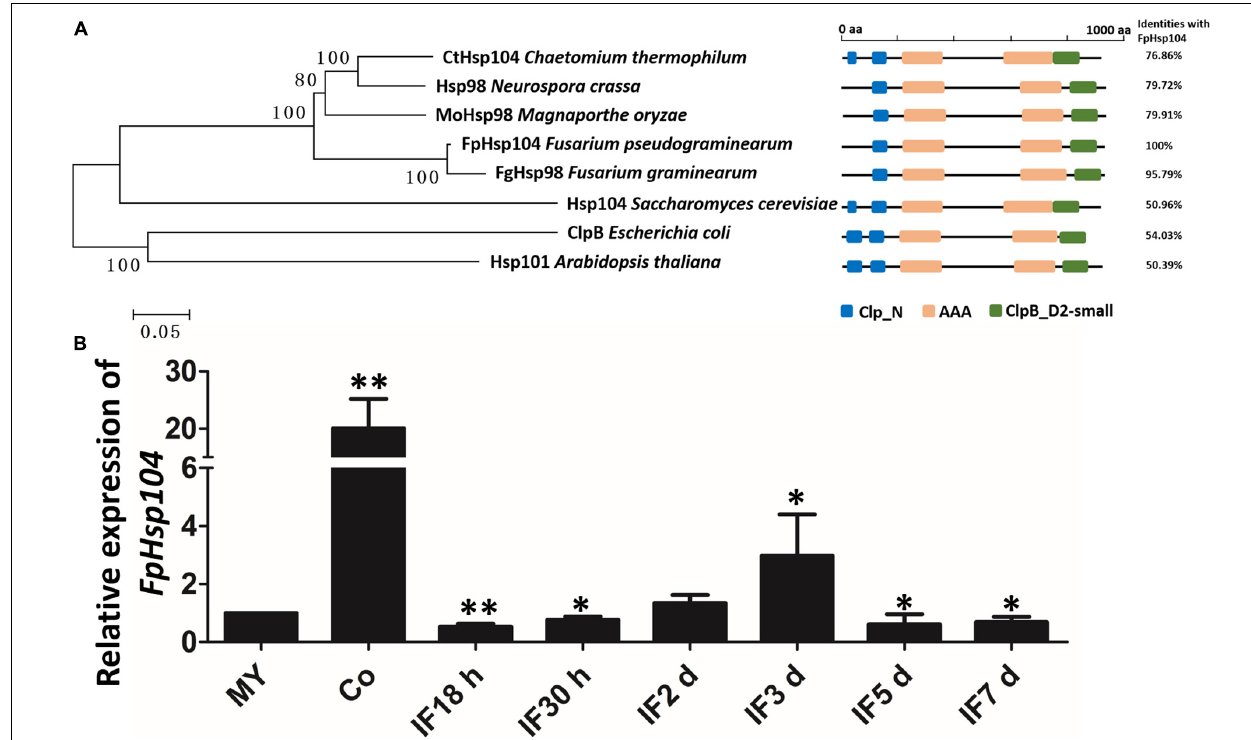
FIGURE 2 | Phylogenetic relationships, domain organization, and gene expression analysis of FpHsp104 in Fusarium pseudograminearum . (A) Phylogenetic tree and domain analyses of selected known Hsp104 proteins. The neighbor-joining tree of fungal Hsp104 orthologs was constructed using the MEGA 5.05 program. Domain annotation was performed using the SMART website. (B) Transcription of FpHdp104 in the infected host was assayed using qRT-PCR. MY, mycelia; Co, conidia; IF 18 h to 7 d, the time points (hours or days) post-infection. Expression levels represent FpHsp104 mRNA levels relative to those of FpTEF1a gene. Bars represent standard deviation based on four replicates. ∗∗ p < 0.01, ∗ p < 0.05 ( t -test).